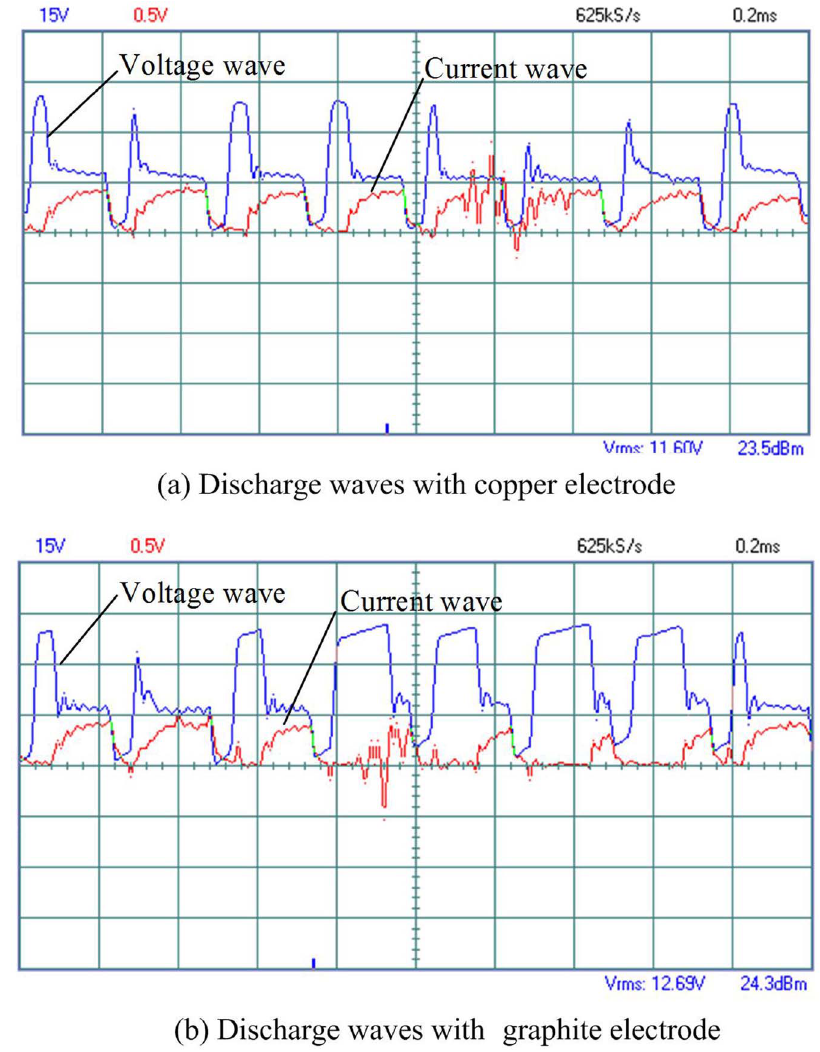
Figure 12. Discharge waves of the ZnO/Al 2 O 3 ceramics with electrical resistivity of 11.64 V ? cm and different electrodes.